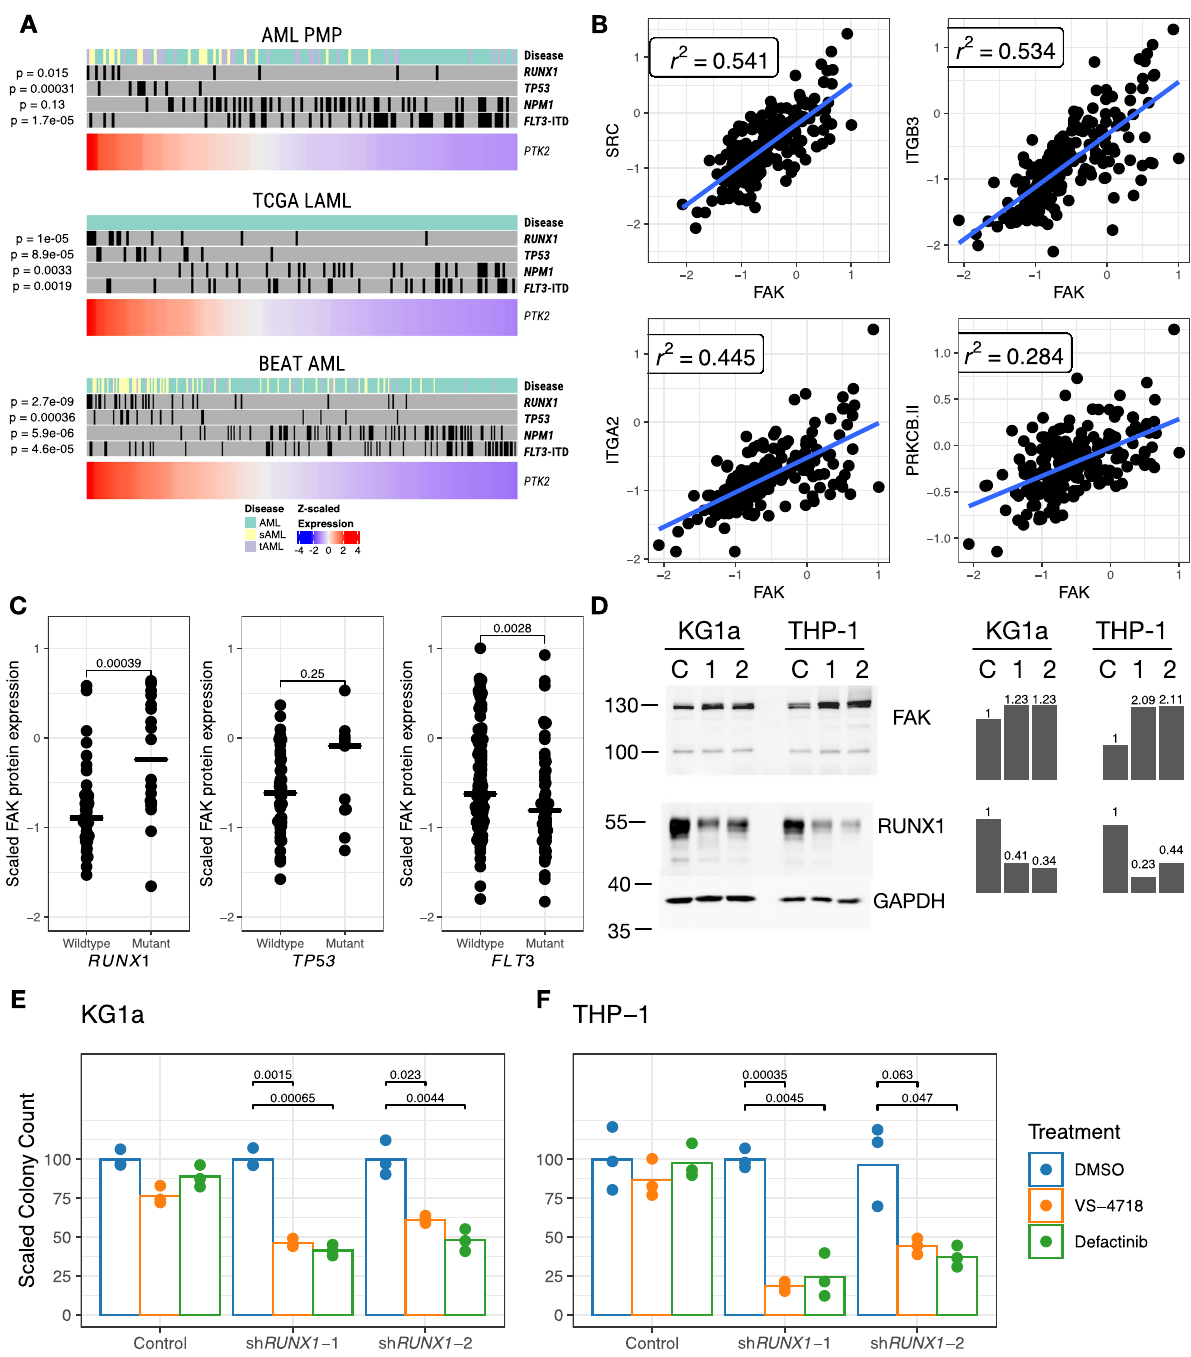
Fig. 8 Correlation of PTK2 expression with speci fi c mutations. A Samples from each cohort ranked by z -scaled expression of PTK2 . The upper annotation plot for each cohort indicates the presence of selected mutations. Indicated p values are for Kruskal-Wallis tests comparing continuous PTK2 expression against presence or absence of speci fi c mutations. B Top highly correlated proteins with FAK. r 2 values indicate Pearson correlation coef fi cients. C Relative FAK protein expression in patients with and without mutant RUNX1 , TP53 , or FLT3 in the AML Proteome Atlas. Two-sided t -test p -values are indicated for each comparison. D Western blot assessment of FAK and RUNX1 expression in KG1a and THP-1 cell line derivatives. Cell lines were treated with either ( C ) control shRNA, (1) sh RUNX1 -1, or (2) sh RUNX1 -2, with molecular weights quanti fi ed in kilodaltons. Quanti fi cations scaled to controls are shown as bar plots. Each blot represents a single experiment, with the exception of RUNX1 in THP-1, which was performed twice with similar results. E , F Colony-forming cell assay for AML cell lines with short-hairpin RNAs against RUNX1 , and treated with FAK inhibitors VS-4718 (0.5 μ m for KG1a, 1.5 μ m for THP-1) or Defactinib (1 μ m for both cell lines). The indicated p values correspond to two-sided t -tests for each